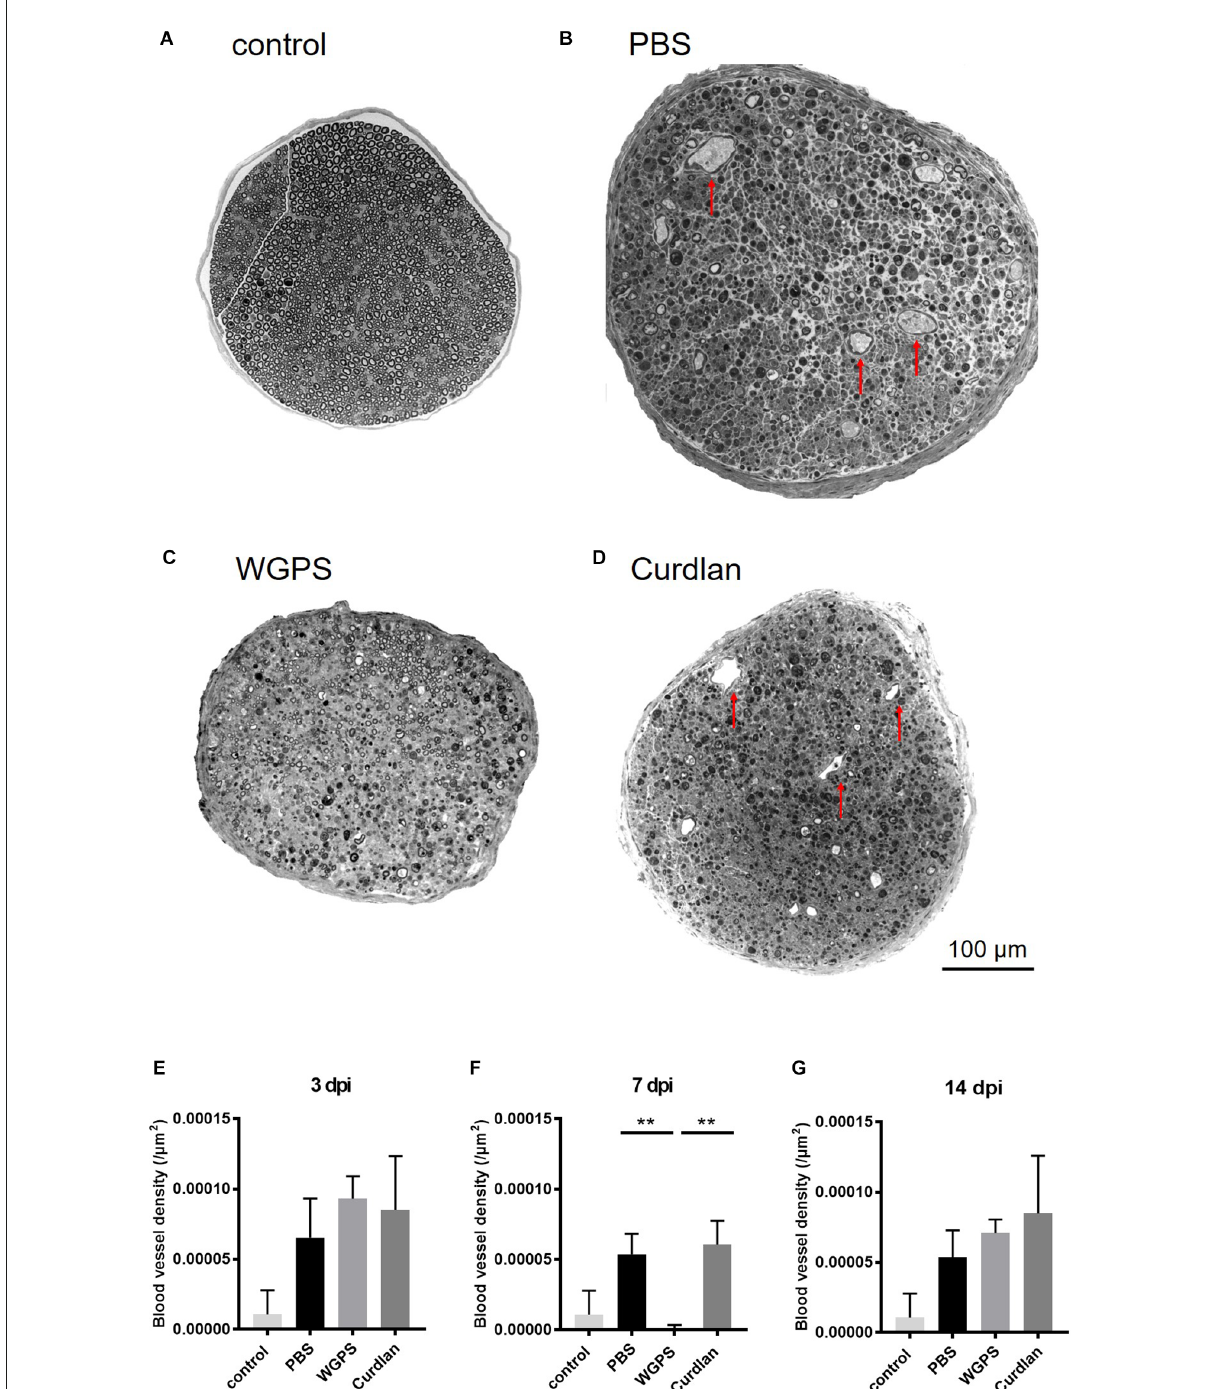
FIGURE7 Semi-thin section morphometry analysis of intraneural blood vessels. Semi-thin cross-sections 1 µ m in thickness of the crushed and injected sciatic nerve distal to the injury were stained with toluidine blue for morphometry analysis. The representative figures are from (A) intact sciatic nerve of sham surgery (contralateral). (B) PBS injected group 7 days after crushing injury (ipsilateral). (C) WGPS injected group 7 days after crushing injury (ipsilateral). (D) Curdlan injected group 7 days after crushing injury (ipsilateral). Arrows indicate blood vessels. Quantitative analysis of intraneural blood vessel density is shown in (E–G) . There was a significant decrease in blood vessel density in the WGPS group 7 days after crushing injury than in the PBS and curdlan groups. Data are represented as median ± SD ( n : control n = 7, 3 dpi: PBS = 4, WGPS = 3, curdlan = 4; 7 dpi: PBS = 5, WGPS = 3, curdlan = 3; 14 dpi: PBS = 3, WGPS = 3, curdlan = 3), ** p < 0.01, dpi: day post-injury. Data obtained from the sham surgery (contralateral) side was denoted as “control” in this